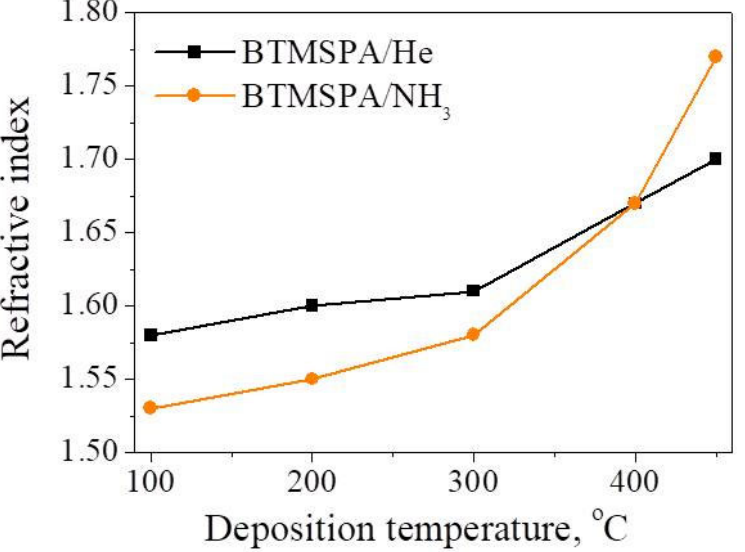
Figure 7. Evolution of refractive index of SiCN films deposited using different reactive mixtures.